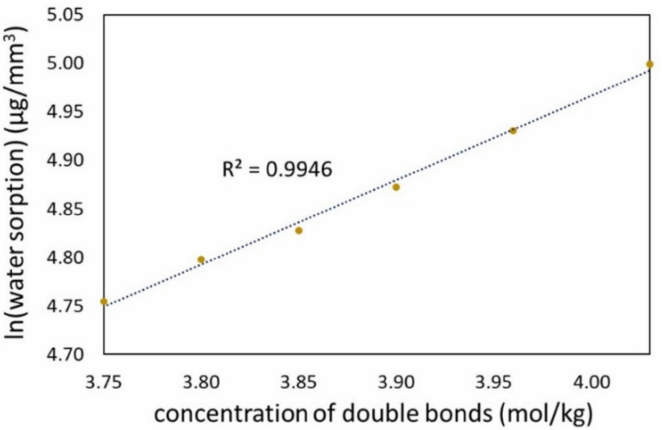
Figure 6. The correlation between the water sorption of the QA:TEG copolymers and the concentra- tion of double bonds in the corresponding monomer compositions. The dotted line - the trendline, the yellow points show the mean values of water